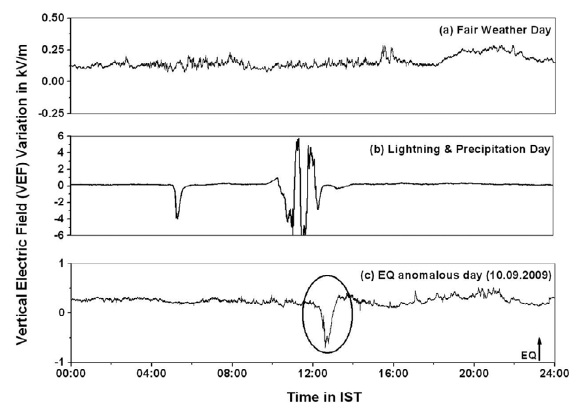
Figure 2. Typical diurnal variations in the VEF for a meteorologi- cally fair-weather day (a), a day with local lightning and precipitation (b), and a day with fair weather and an anomalous VEF variation that preceded an earthquake (c). Arrow, time of the main strike of the earthquake.